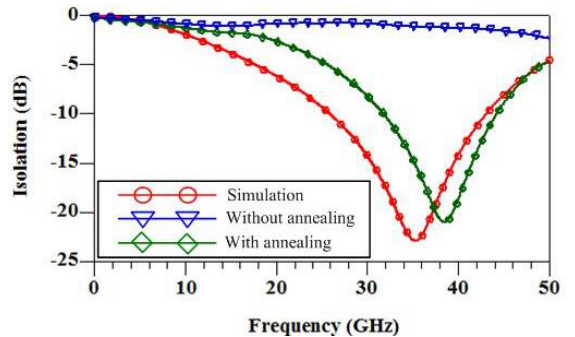
Figure 7. Isolation of the RF switch.